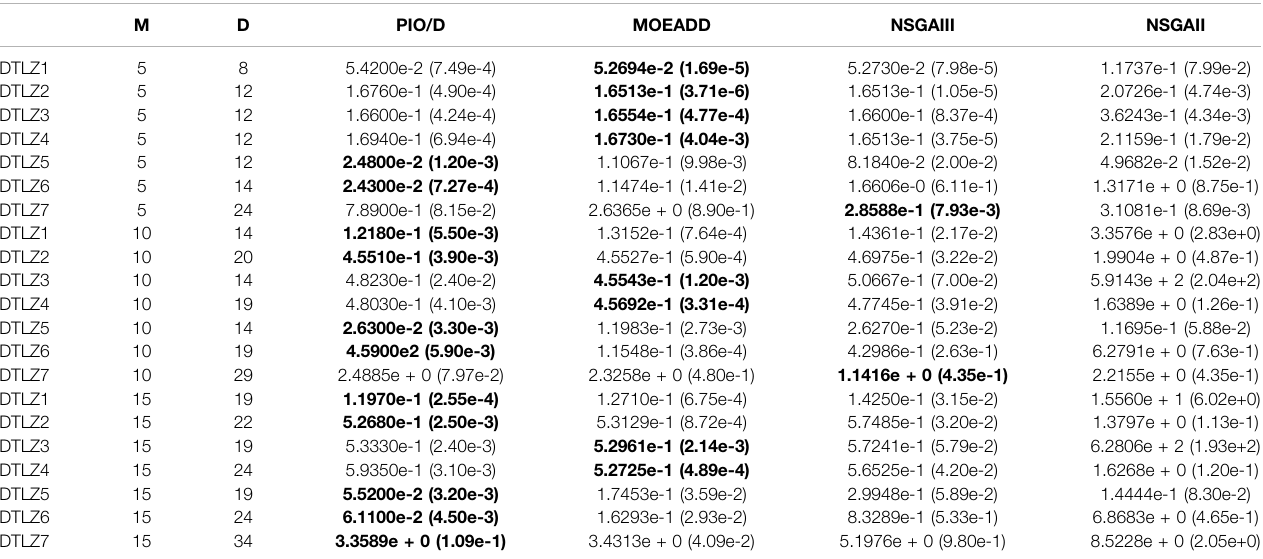
TABLE 4 | PIO/D, MOEADD, and NSGAIII give the mean and standard deviation of the IGD